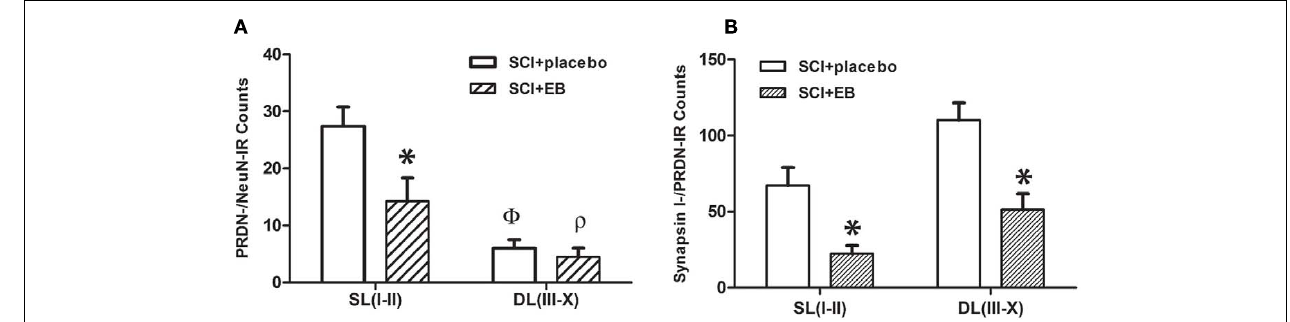
to the EB-treated SCI group in both regions, the SLI-II and DLIII-X (* p < 0.05, for both). Before counting, the gray matter was divided into SL I-II and DL III-X based on the “The Rat Brain in Stereotaxic Co-ordinates” by Paxinos andWatson (1998), as shown in the schematic in Figure 2B . A complete optical section (1 μ m) taken from the center of stacks of confocal images was counted. Counts shown on the x -axis are mean ± SEM per section ( n = 4–5), and was analyzed by a two-way ANOVA. Abbreviations are as in the Figure 1